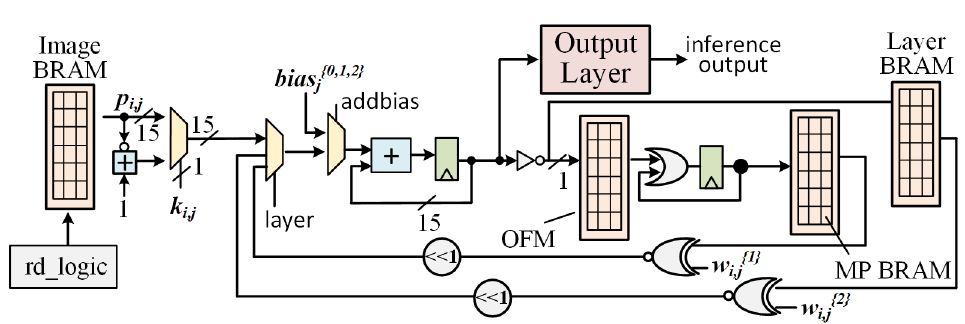
Figure 13: Hardware design of the unprotected binarized